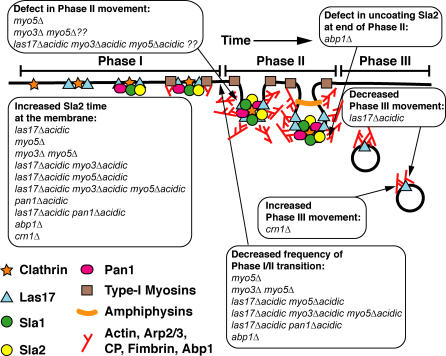
A Model for Endocytosis and Actin Patch Assembly, with a Summary of the Requirements for Individual Arp2/3 Regulatory ProteinsDuring phase I, almost all of the Arp2/3 regulators have a role in promoting assembly. At this stage, Arp2/3 regulators presumably act to establish a proper actin network with appropriate filament lengths and branch density. During phase II, Arp2/3 regulation is complex. Mutation of no single Arp2/3 regulator affected this stage, but simultaneous mutation of the Arp2/3 binding regions of WASp/Las17, Myo3, and Myo5 did disrupt this movement. Capping protein also has a role at this stage [33]. During phase III, several lines of evidence support a model where actin filaments, nucleated at the actin patch, drive movement of the vesicle through the cytoplasm. In this model, barbed ends are oriented toward the vesicle (see Discussion).